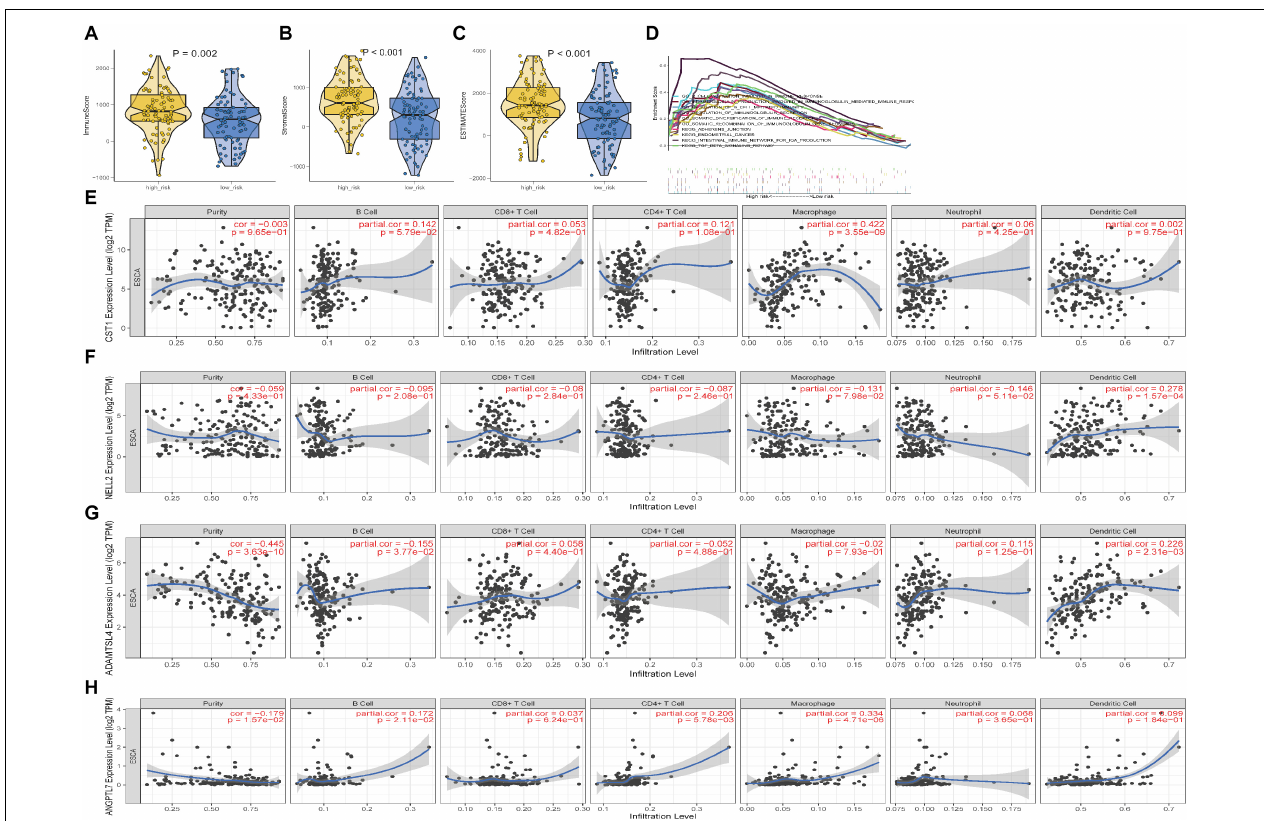
FIGURE 10 | Characterisation of the TME and tumour-infiltrating immune cells in ESCC. (A–C) Immune, Stromal scores and ESTIMATE scores of the high- and low-risk groups in ESCC. (D) Gene set enrichment analysis between the high-risk and low-risk groups. (E–H) The correlation between the expression levels of the four genes and immune cell infiltration in